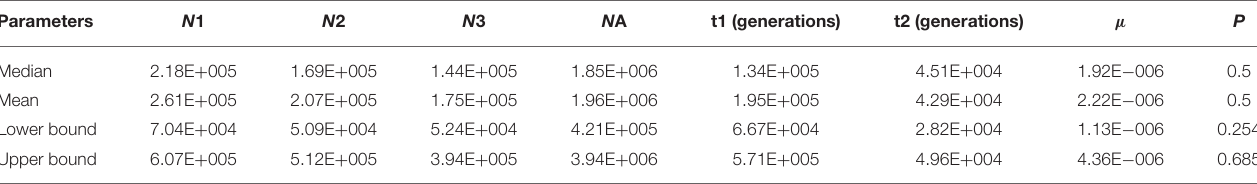
TABLE 6 | Demographic approximate Bayesian computation (ABC) models for Rhinopithecus roxellana in Qinling Mountains.